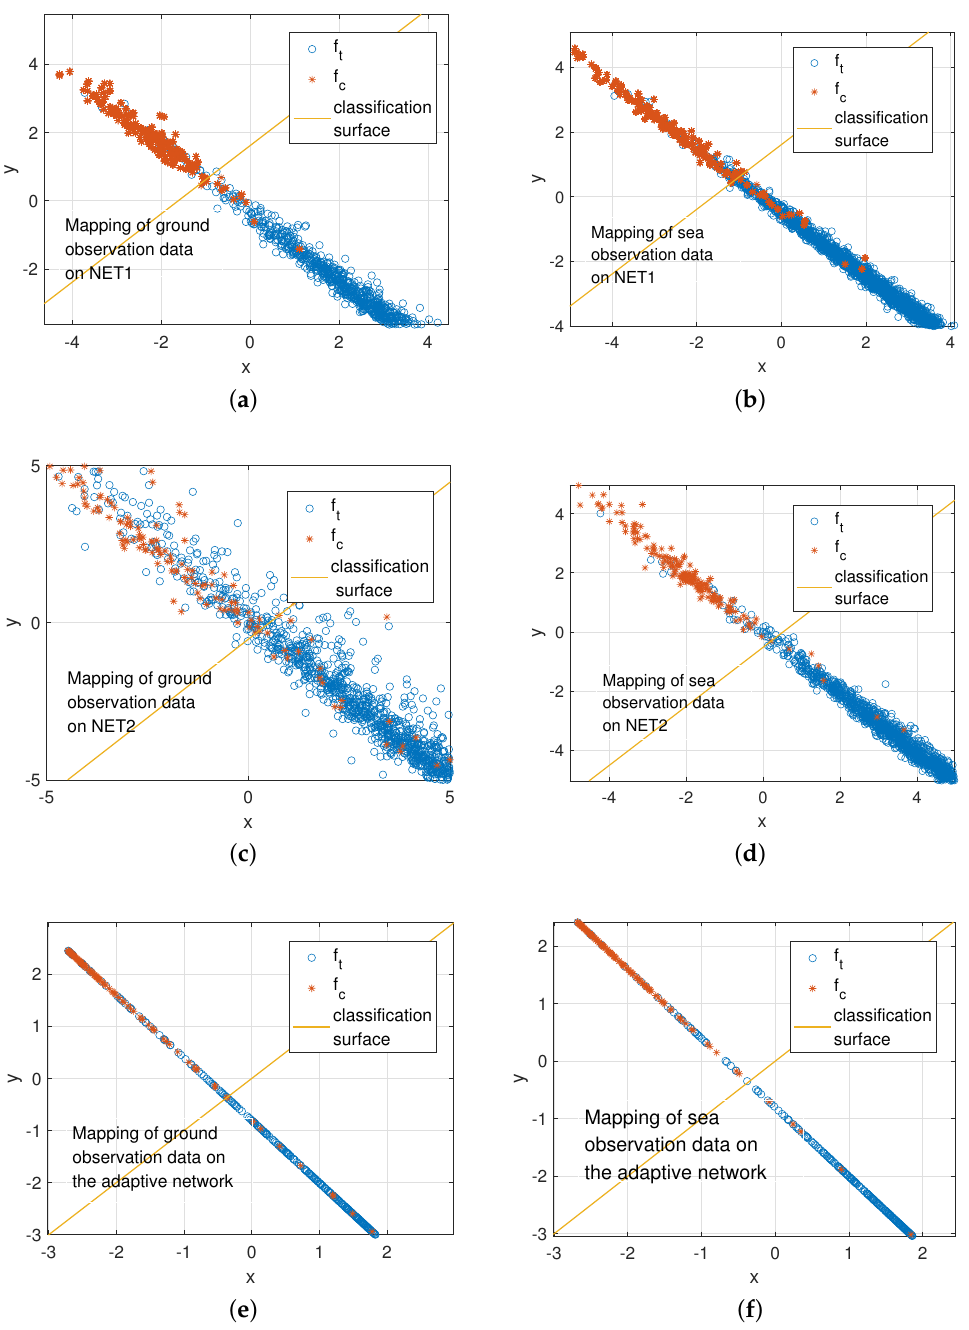
Figure 6. Distribution of samples in the new feature space. ( a , d ) shows the feature distribution when the test data is consistent with the detection network scene, ( b , c ) shows the feature distribution when the test data is inconsistent with the detection network scene, and ( e , f ) shows the feature distribution of the two test data in the adaptive network. It proves that the proposed method can gather the common class data together and separate clutter and target to realize the data adaptive target